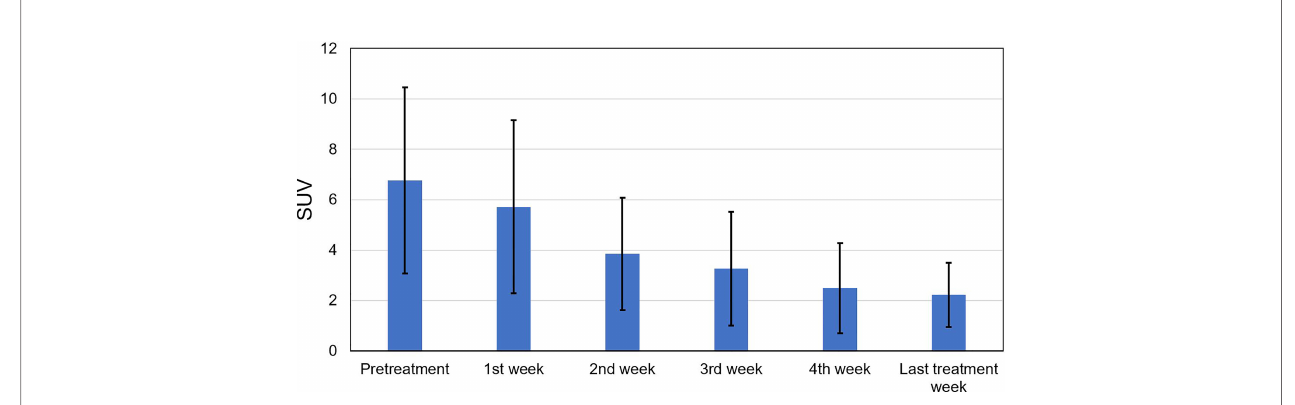
FIGURE 2 | Standard uptake value (SUV) measured at the pretreatment, the 1st to 4th treatment weeks, and the last treatment week for all tumor voxels.